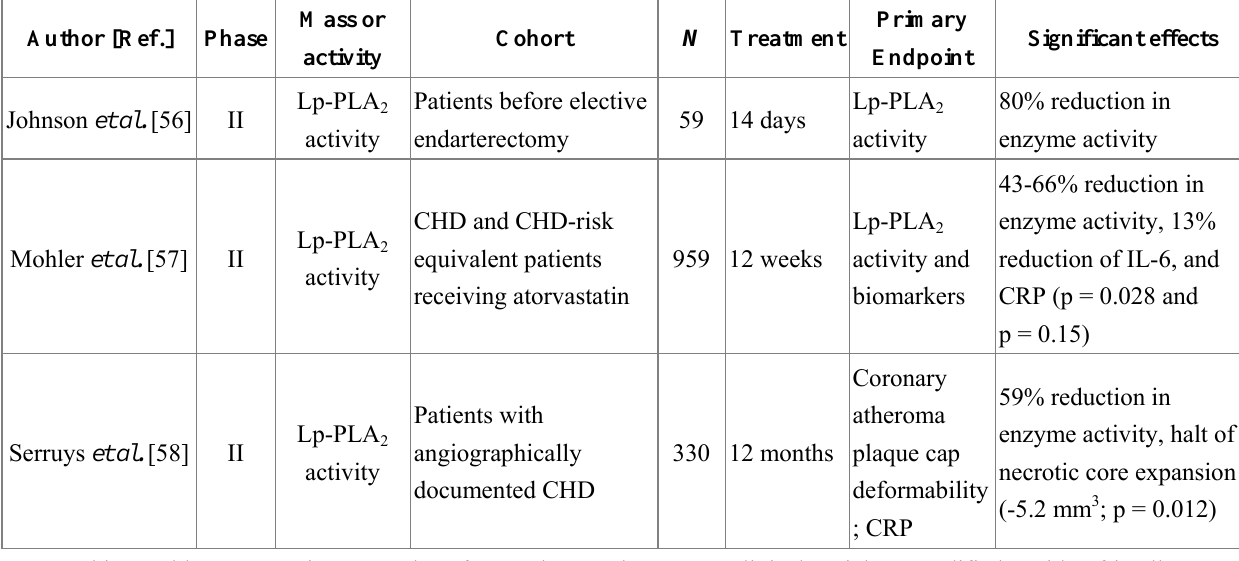
Table 1. Clinical trials evaluating